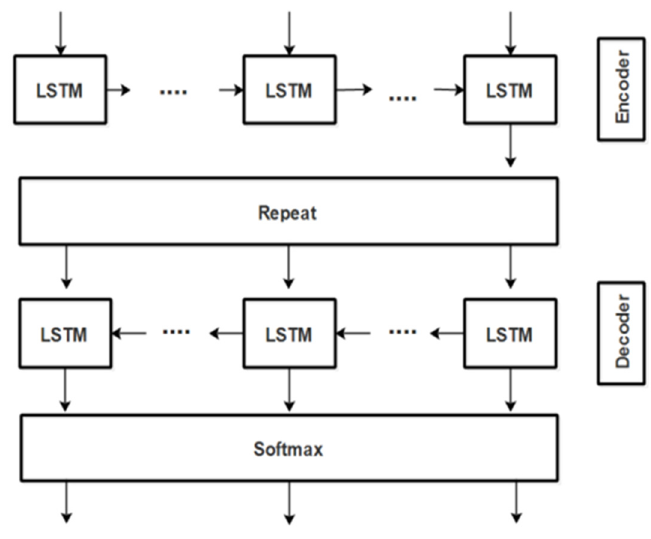
Figure 5. Encoder–decoder functionality of our Bi-LSTM.